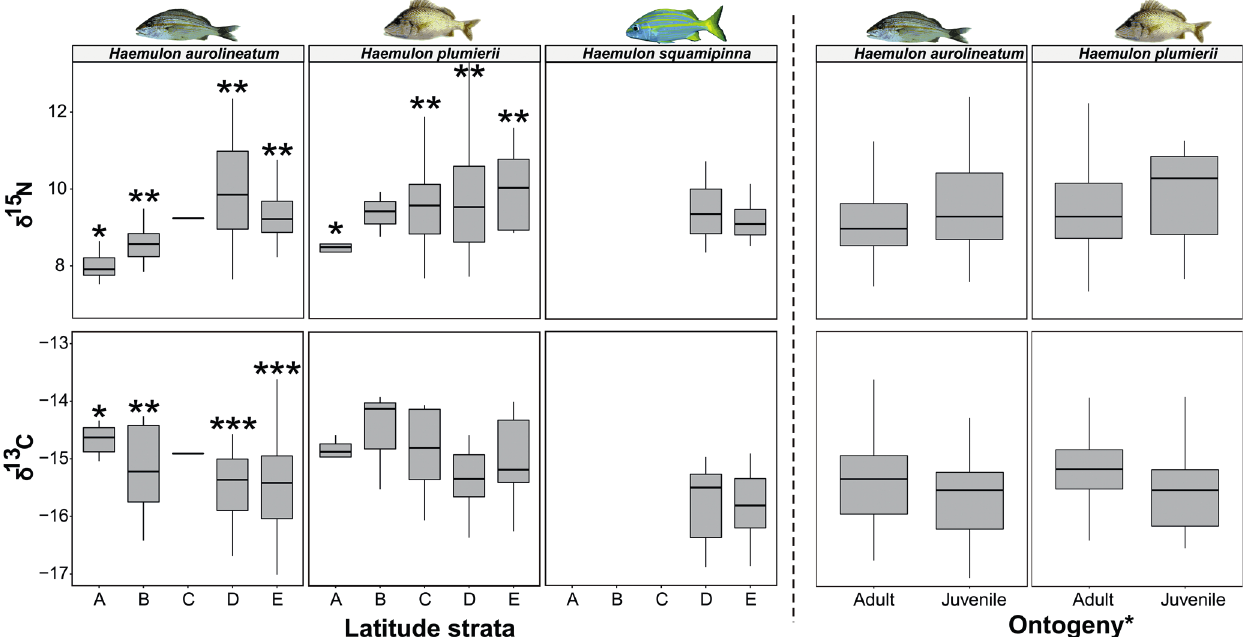
FIGURE 5 | Isotopic ratios of carbon ( δ¹³ C) and nitrogen ( δ 15 N) of Haemulon plumierii , H. aurolineatum and H. squamipinna in different latitude gradient and ontogeny captured along the northeast coast of Brazil. The black horizontal line and box represent the median value and the interquartile range, while the vertical lines represent the upper and lower limits. Outliers were not included in the plot. *All caught specimens of H. squamipinna were considered adults, not allowing ontogenetic analysis. Different symbols (*, ** and **) represent significant difference. Ontogeny* - All caught specimens of H. squamipinna were considered adults, not allowing ontogenetic analysis.